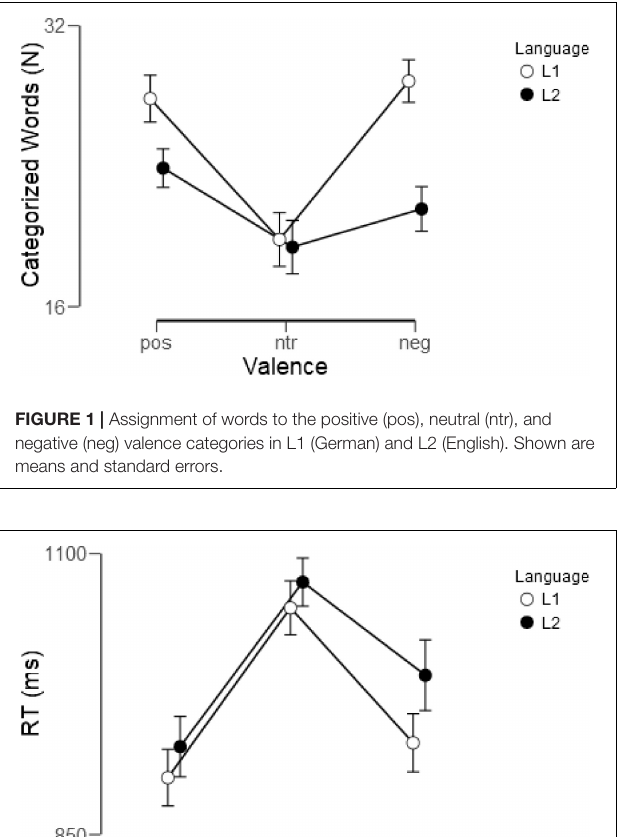
TABLE 5 | Reaction times for evaluative decisions.